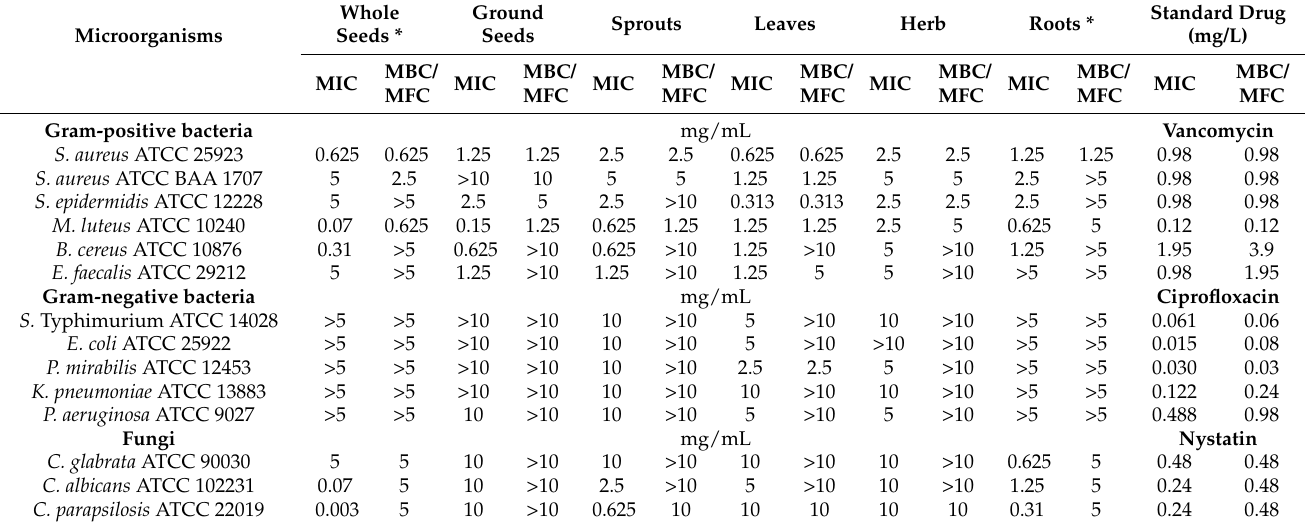
Table 3. The antibacterial and antifungal activities of seeds, sprout, leaf, root and herb extract S. hispanica